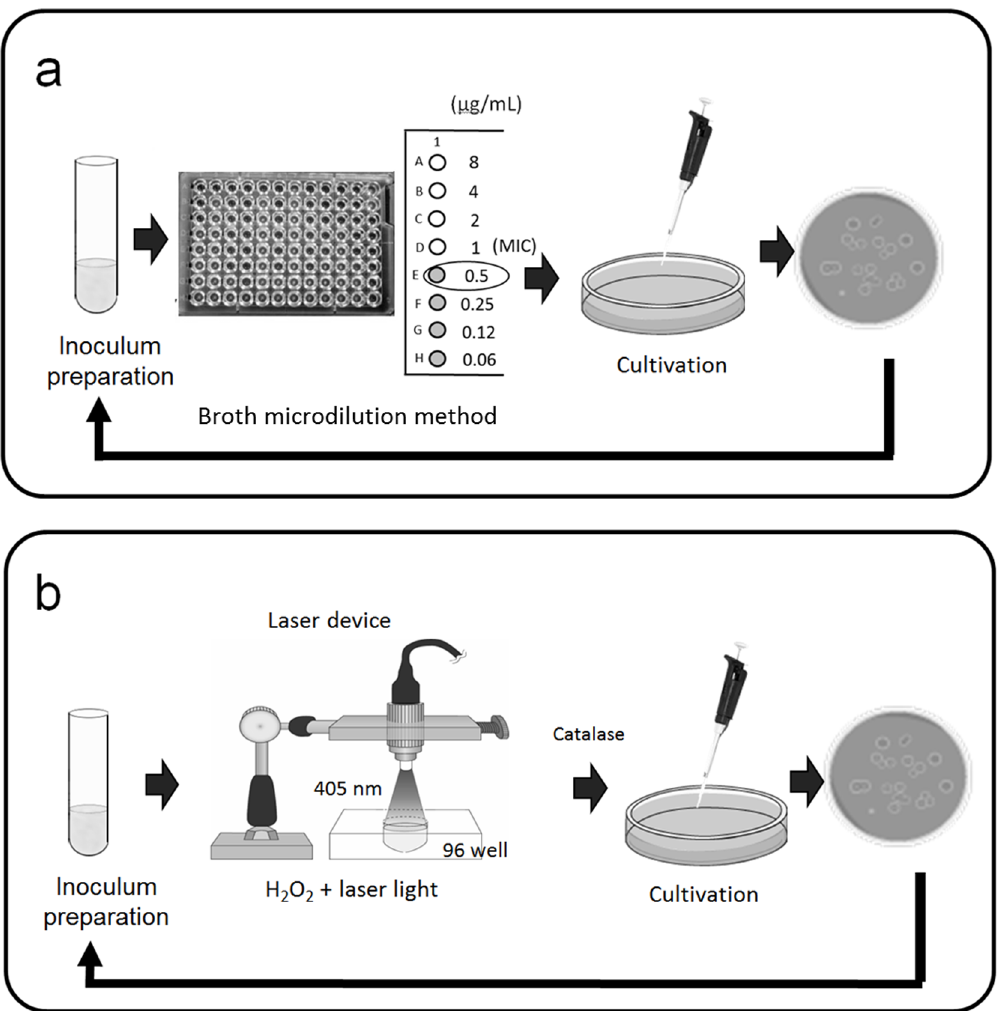
Figure 1. Schematic illustrations of susceptibility testing. (a) Antibacterial agents and (b) disinfection treatment with photolysis of H 2 O 2 are shown.